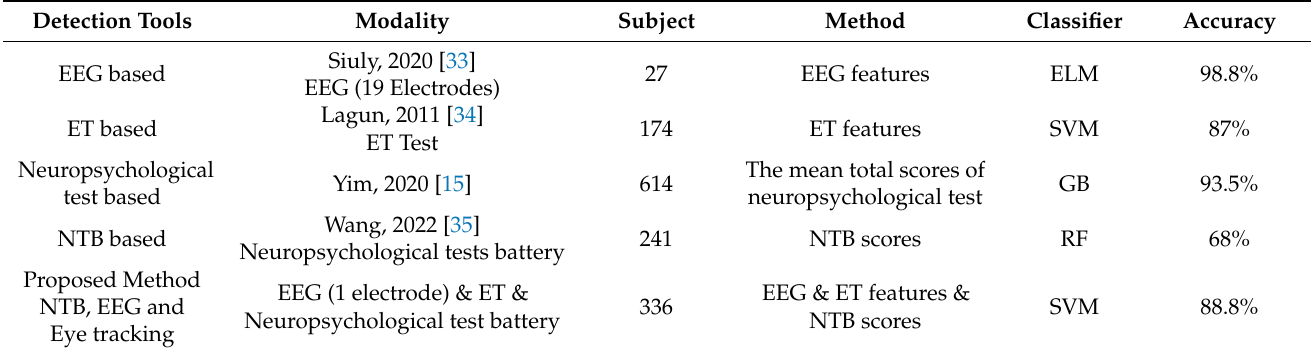
Table 5. The performance of analogous MCI detection methods in the